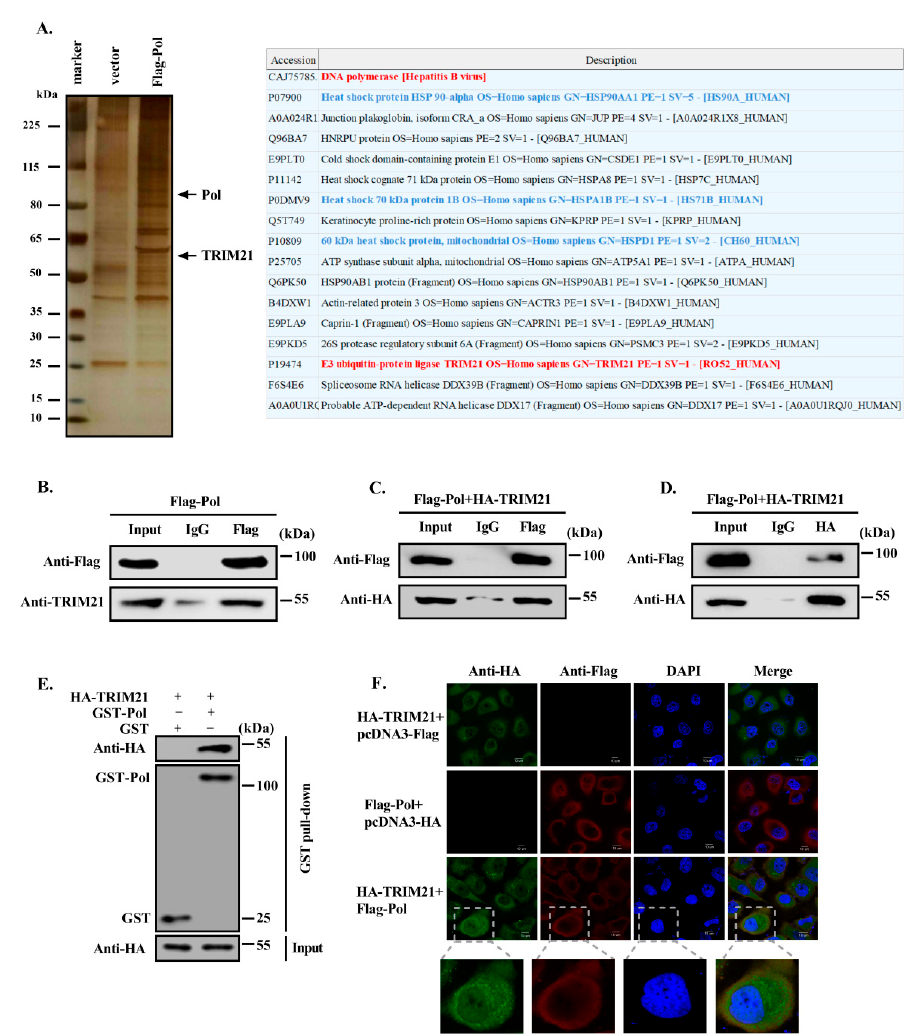
Figure 1. TRIM21 interacts with HBV DNA Pol. ( A ) Huh7 cells were transfected with FLAG-HBV DNA Pol and vector control, and FLAG affinity beads were used to precipitate all proteins that might interact with HBV DNA Pol. The interacting proteins of HBV DNA Pol were screened by mass spectrometry. Some potential interacting partners of HBV DNA Pol are listed. Red marks the target protein, blue marks proteins that have been reported to interact with HBV DNA Pol. Data are representative of two independent experiments. ( B ) The FLAG-HBV DNA Pol expression plasmid was transfected into Huh7 cells. After 36h, a co-IP assay was carried out with anti-FLAG antibody and control IgG antibody. HBV DNA Pol was then detected with anti-FLAG antibody, and anti-TRIM21 antibody was used to detect the endogenous expression of TRIM21 in Huh7 cells by Western blot. ( C ) Huh7 cells were cotransfected with FLAG-HBV DNA Pol and HA-TRIM21, and co-IP was performed as described in ( B ) to detect the expression of HBV DNA Pol and TRIM21. ( D ) Huh7 cells were transfected as described in ( C ), co-IP was performed with anti-HA antibody, and HBV DNA Pol and HA-TRIM21 expression were detected by Western blot. ( E ) GST-HBV DNA Pol and HA-TRIM21 were transfected into Huh7 cells, 36h after transfection, GST beads were used to pull down GST-Pol with its interacting proteins. HBV DNA Pol was detected with anti-GST antibody, and anti-HA antibody was used to detect the expression of TRIM21. ( F ) FLAG-HBV DNA Pol and HA-TRIM21 were transfected into Huh7 cells; 36h after transfection, the mouse anti-FLAG TRITC-conjugated monoclonal antibody and rabbit anti-HA FITC-conjugated polyclonal antibody were used to stain the cells, and the DAPI were used to stain the nuclei. Then, confocal microscopy images were collected and analyzed for the colocalization of HBV DNA Pol and TRIM21. The scale is 10 µ m. Data are representative of three independent experiments with three replicates